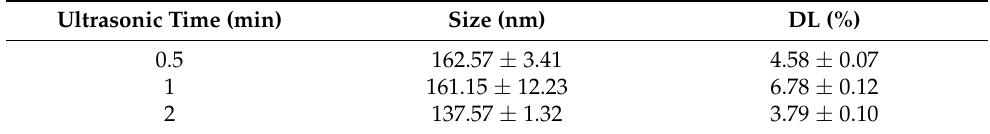
Table 4. Effect of ultrasonic time on